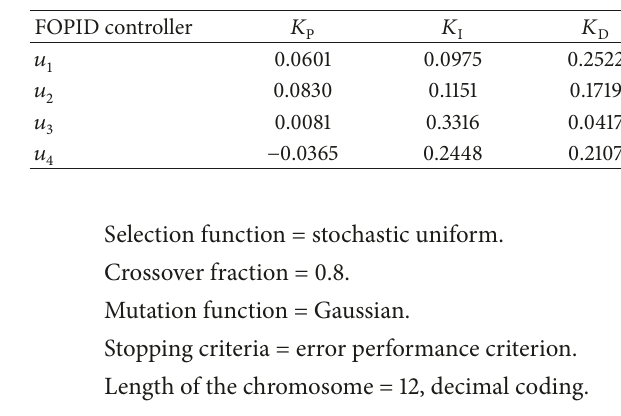
Table 1: FOPID controller gain values optimized with